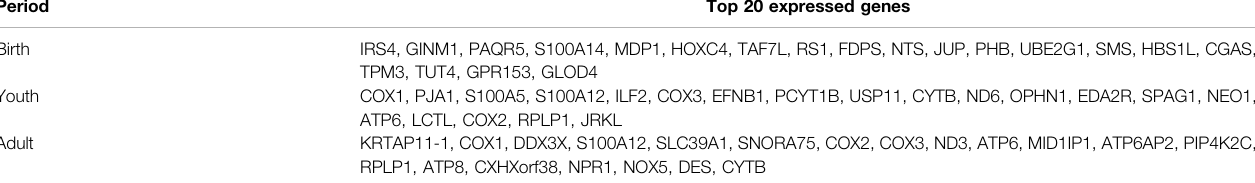
TABLE 1 | Top 20 expressed genes in the rumen tissues at three periods. Period